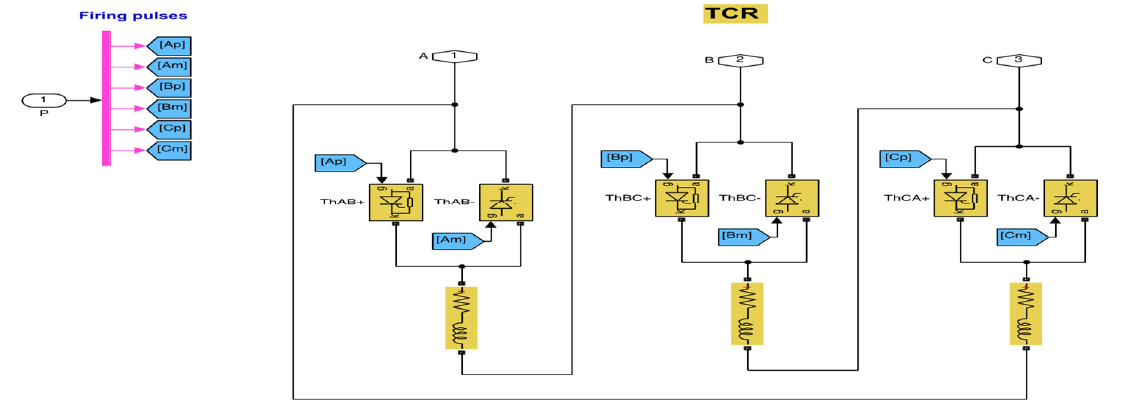
FIG. 2. THYRISTOR CONTROLLED